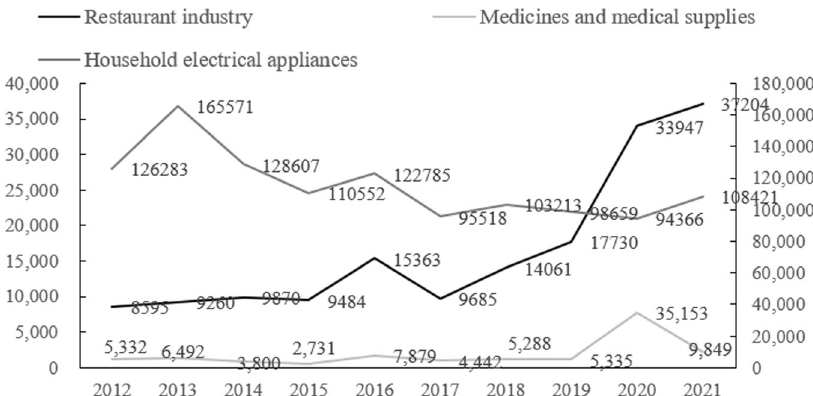
Fig. 2 Complaint volumes about the restaurant industry, medicine and medical supplies, and household electrical appliances from 2012 to 2021 ( n ). It presents the complaint volumes about the restaurant industry, medicine and medical supplies, and household electronic appliances with different color lines from 2012 to 2021. The growth trends for complaints of different types were not the same.